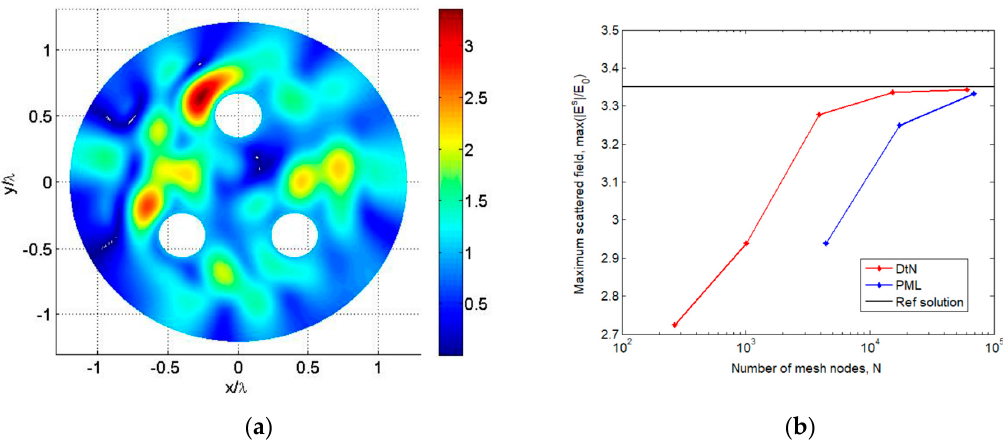
Figure 6. Case study 3 (cable bundle with dielectric). ( a ) Map of the amplitude of the scattered field, normalized to that of the incident field. The axes x and y are normalized to the wavelength value. ( b ) Maximum value of the scattered field, normalized to amplitude of the incident field, versus the number of mesh nodes: The DtN and PML solutions are compared to the reference one.